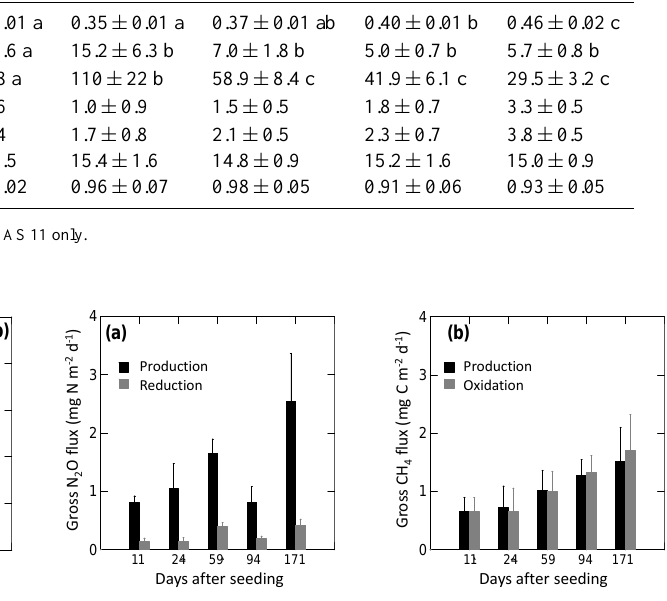
Table 2. Soil characteristics and N cycling rates across all sampling dates by soil depth in the gross flux transect (mean ± SE). Variable